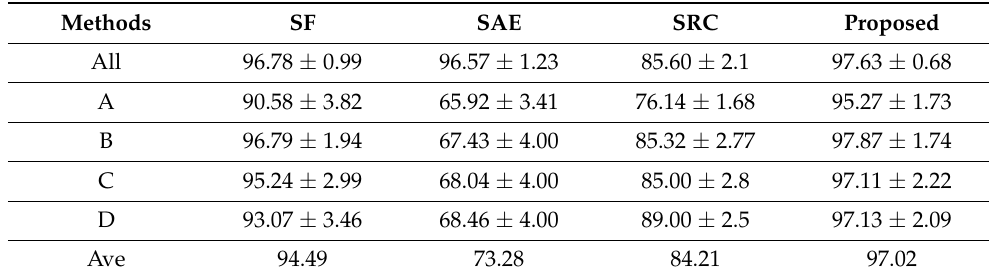
Figure 10. Bearing diagnosis results of the three methods under various working conditions. Table 4. The detailed diagnostic results (%) of the bearing data.